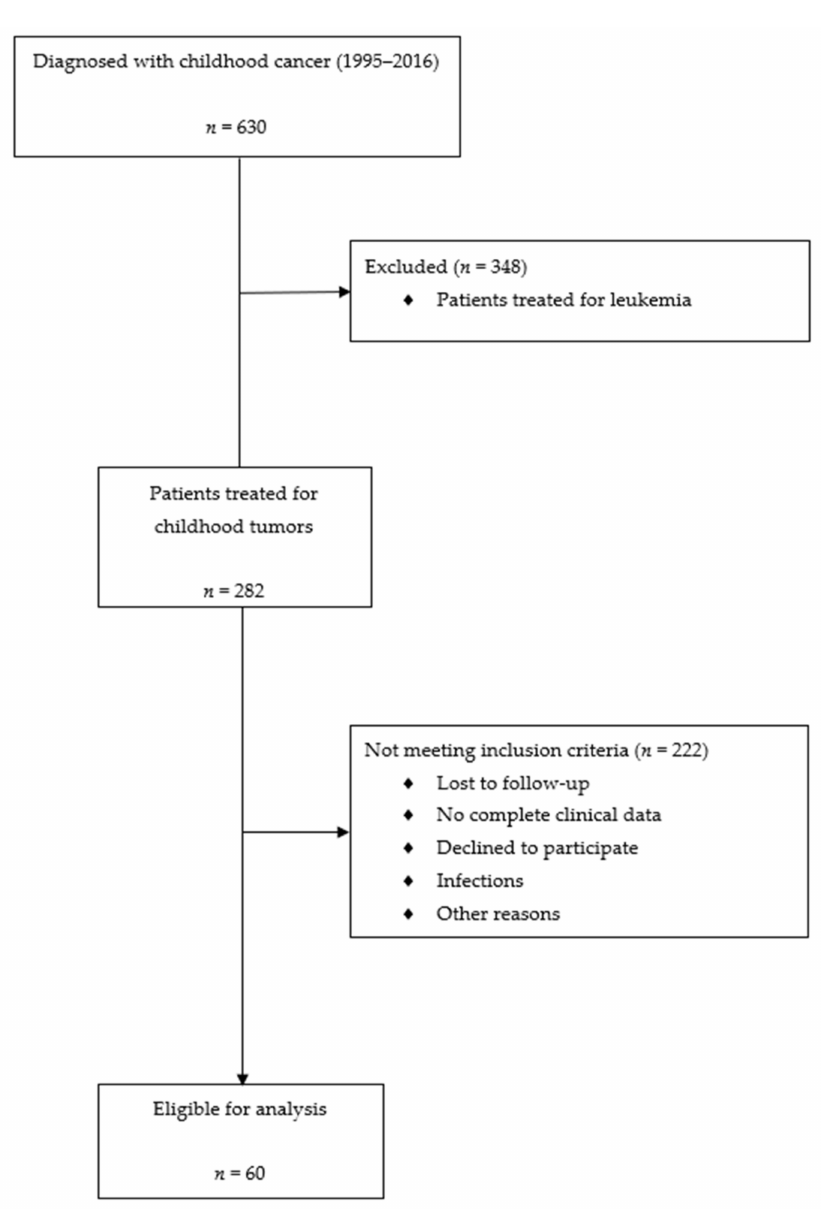
Figure 1. Flow chart describing the design of the cross-sectional study conducted among survivors of childhood solid